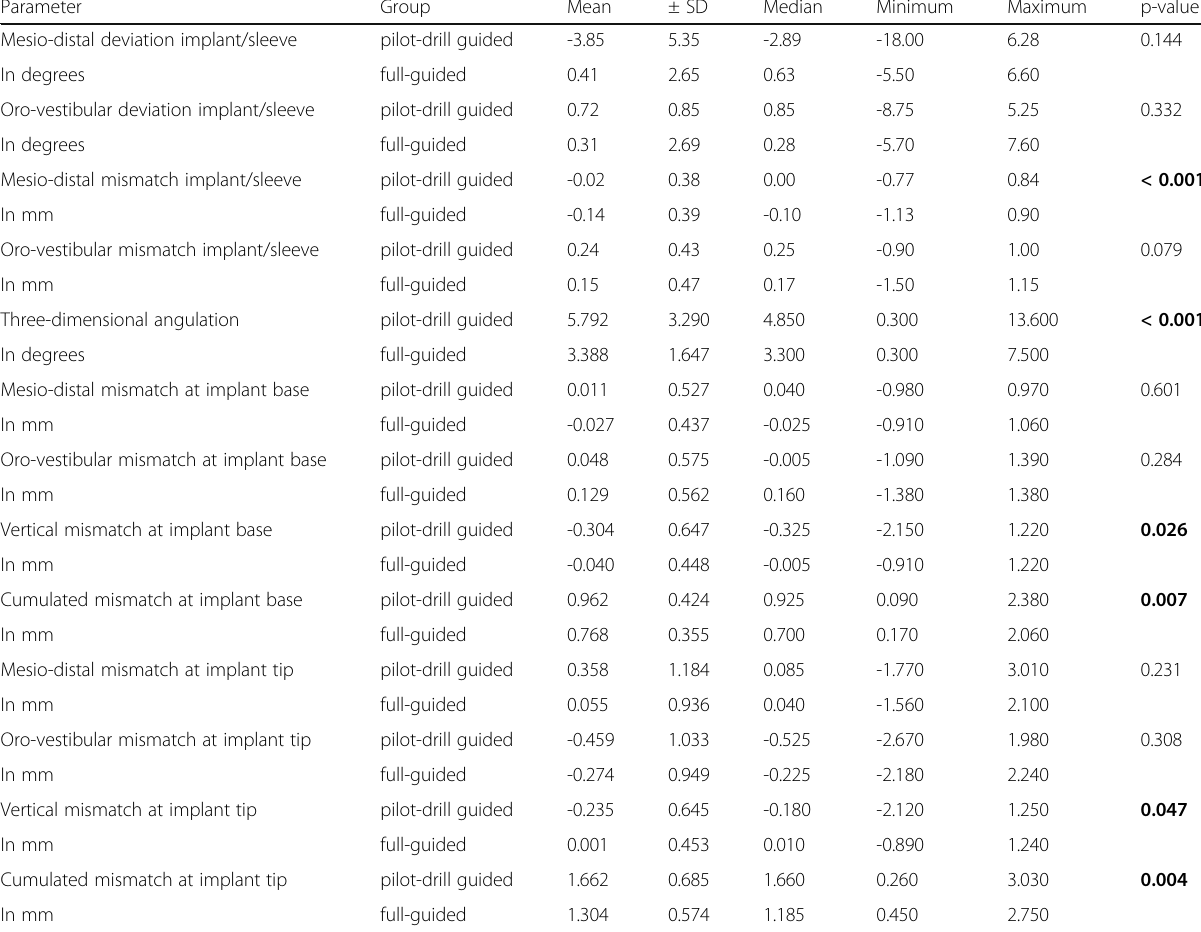
Table 2 Comparison of deviations and angulations between pilot-drill guided and full-guided implant insertion. The means, their standard deviations (SD), medians, minima and maxima are shown. The p-values are resulting from a pair-wise comparison. P-values for statistically significant differences are marked in bold